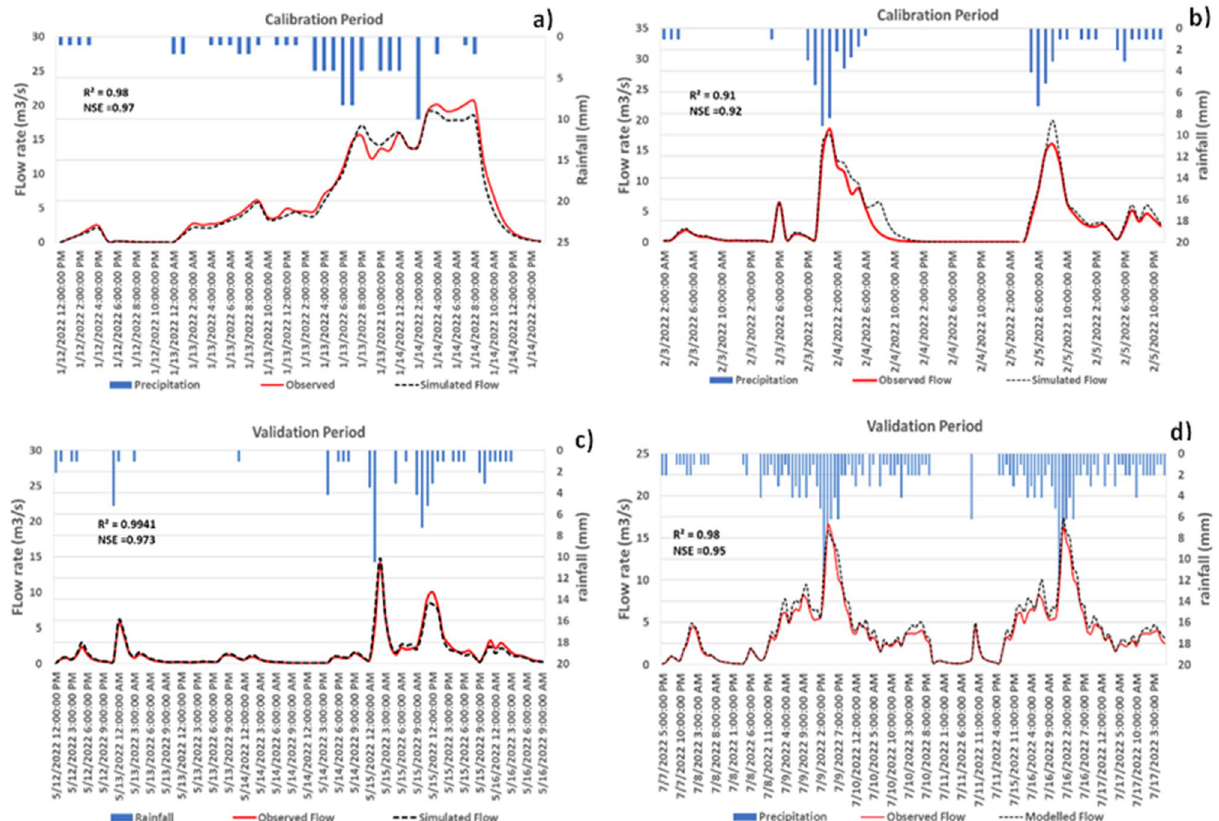
Figure 8. Model performance in simulating the observed flow hydrograph corresponding to the selected rainfall event (8th October 2021) for calibration and validation.